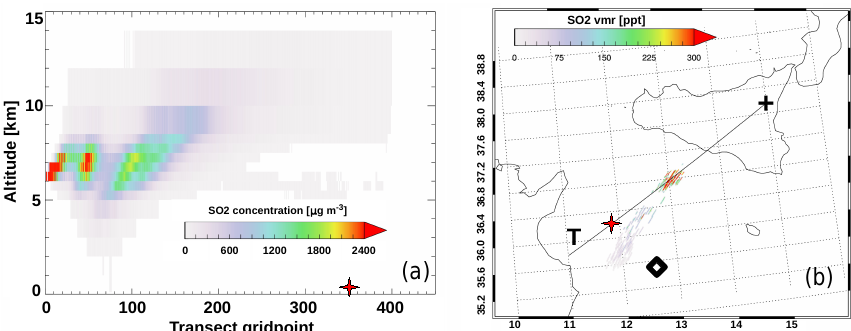
Figure 6. (a) Sulfur dioxide vertical concentration profiles (in µgm − 3 ) along trajectory T and (b) the mean volume mixing ratio (in ppt – parts per trillion) in the altitude range from 10 to 14km, from FLEXPART simulations, for 26 October 2013, 12:20 UTC. Violet–grey to red pixels indicate relatively low to high concentration values. The red cross marks the same grid points in (a) and (b) . The position of Lampedusa is indicated with a black diamond; the position of Mount Etna is indicated with a black cross in (b)